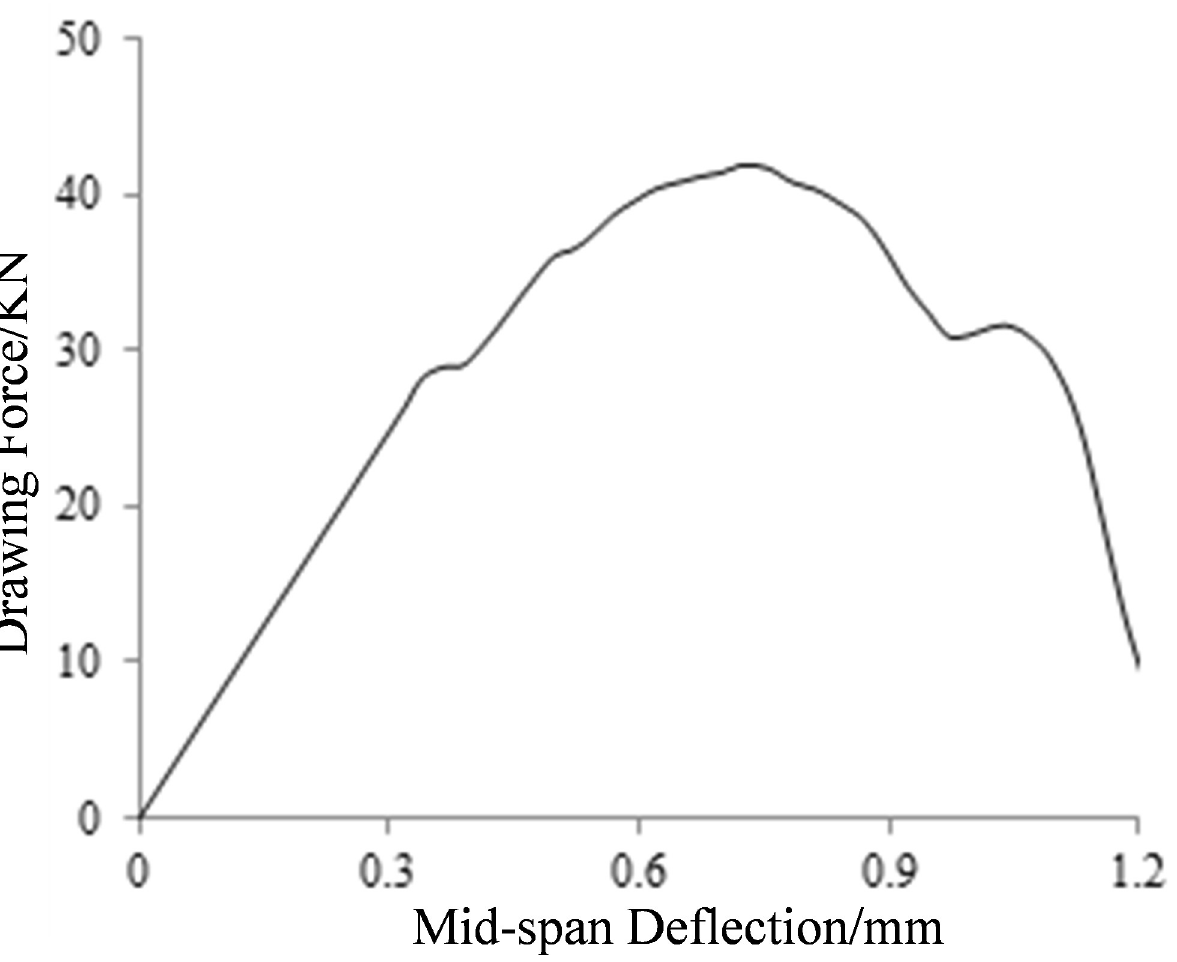
Fig 16. The relationship between the drawing force and mid-span